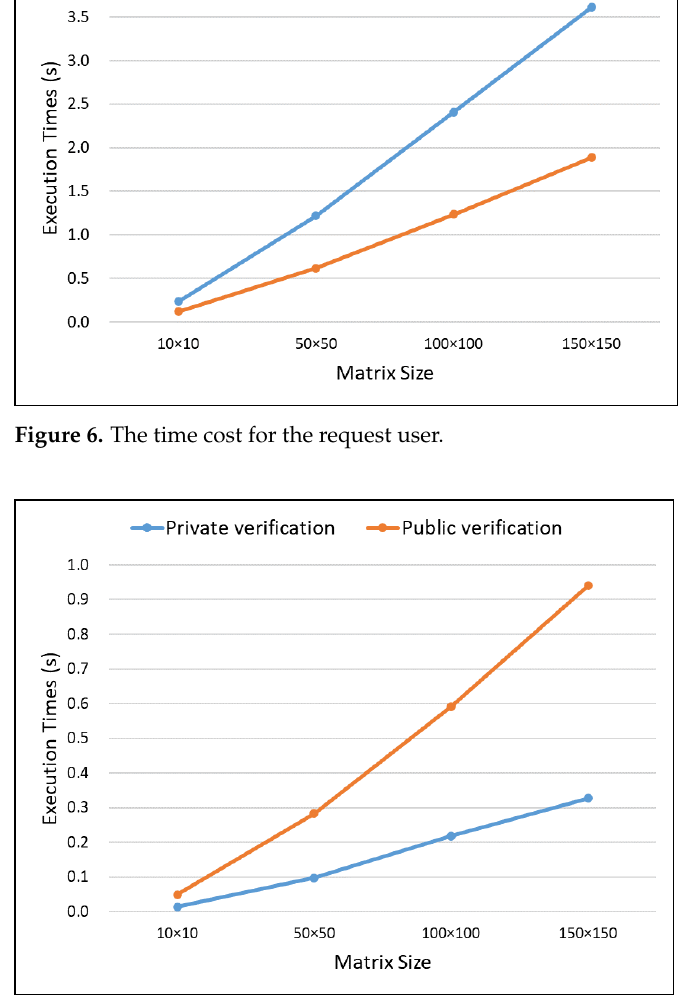
Figure 7. The time cost for